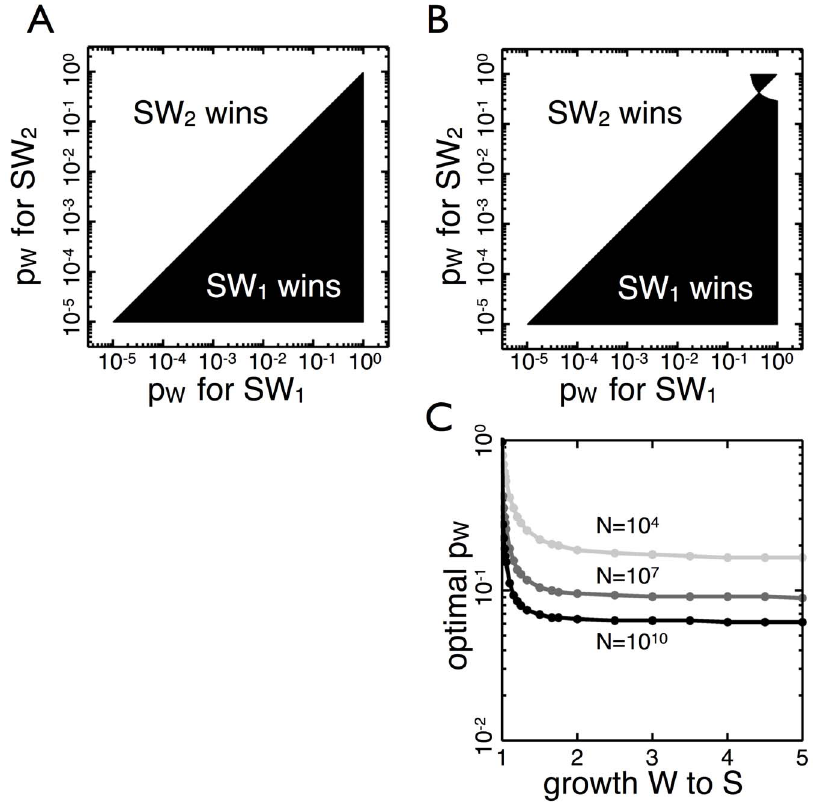
Figure 4. The effect of the maladapted type’s growth on the optimal transition probability. (A) Two SW organisms compete ( N ~ 10 7 ) with different transition probabilities, p w , when W types grow at the same rate as S types– when the cost of maladapted type ( W ) is minimal. Without a penalty for producing W types the organism with the higher p w always wins. (B) W types grow 1% slower than S types ( N ~ 10 7 ). The optimal transition probability decreases and the top black area of the transition probability competition graph increases. (C) The optimal p w is shown as a function of the growth discrepancy between S and W types for three different values of N . The optimal transition probability when W types grow by a factor of 1.5 times slower than S types is approximately the same as when the W types do not reproduce at all.